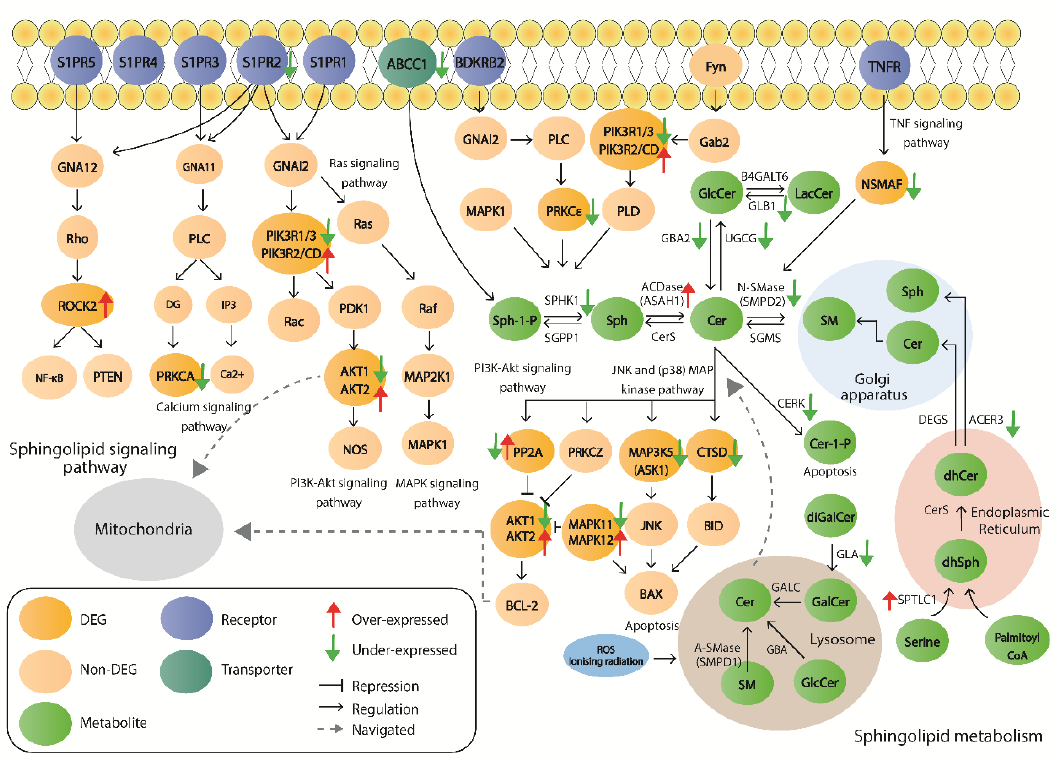
Figure 5. Schematic representation of sphingolipid signaling pathway and sphingolipid metabolism. The DEGs of neuronal “ataxia” datasets are presented. Green arrows represent under-expression and red arrows over-expression. The genes designated by both red and green arrows represent different expression change in datasets of different tissues (under-expressed in one tissue, over-expressed in another).